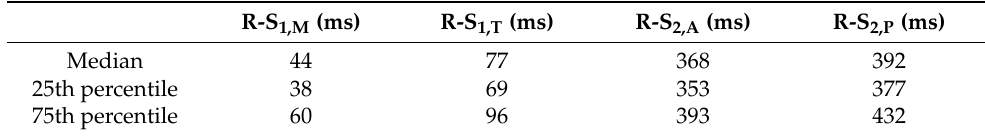
Table 2. Median, 25th percentile, and 75th percentile values for the four latencies over the sample population. The median value is used as reference for the computation of the percentage